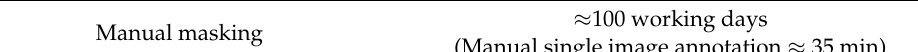
Table 4. Comparison of the annotation times between manual masking and AI masking.